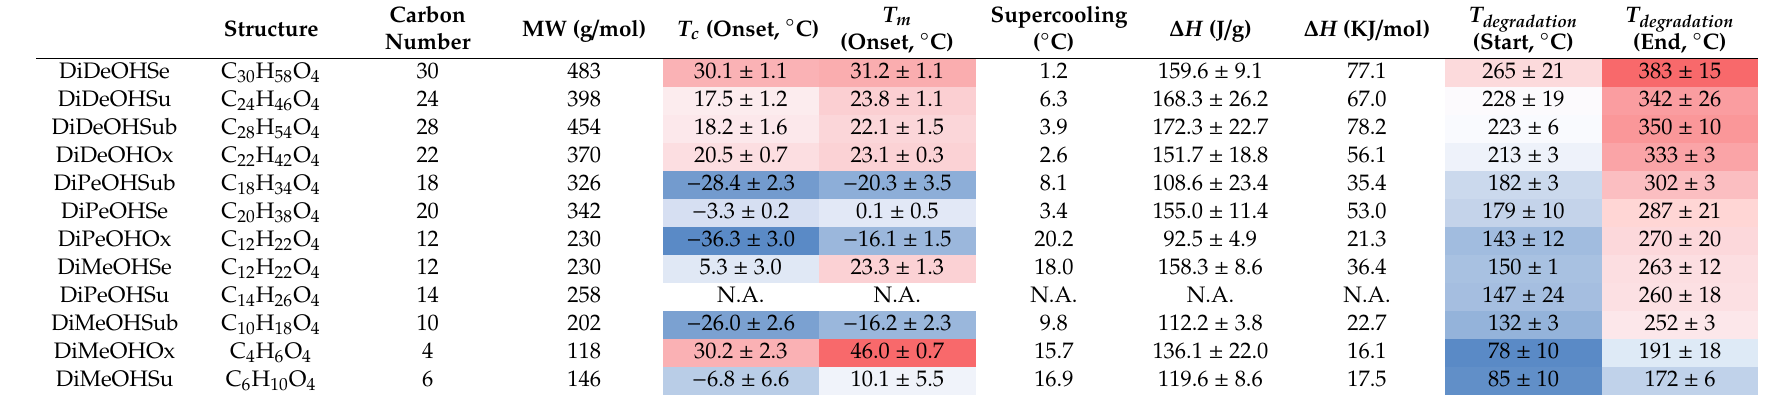
Table 3. Data shown in Table 2, reordered according to decreasing T degradation end, from the highest values (red) to the lowest ones